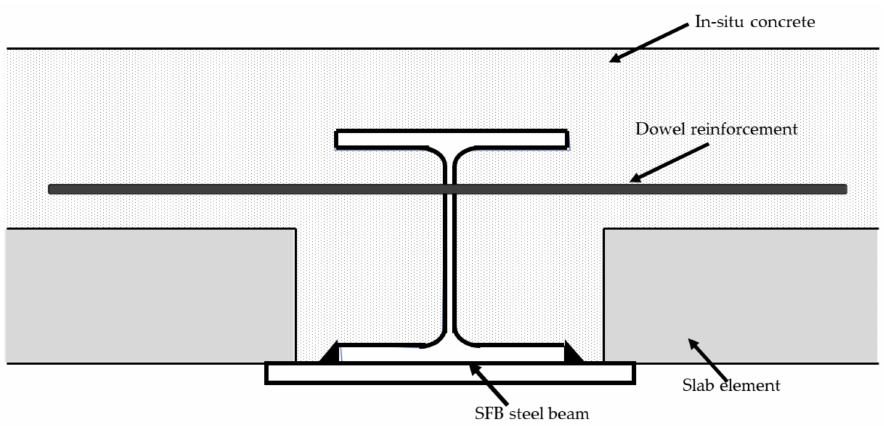
Figure 2. Composite slim floor beam (CoSFB) with dowel reinforcement–composite behavior [7].